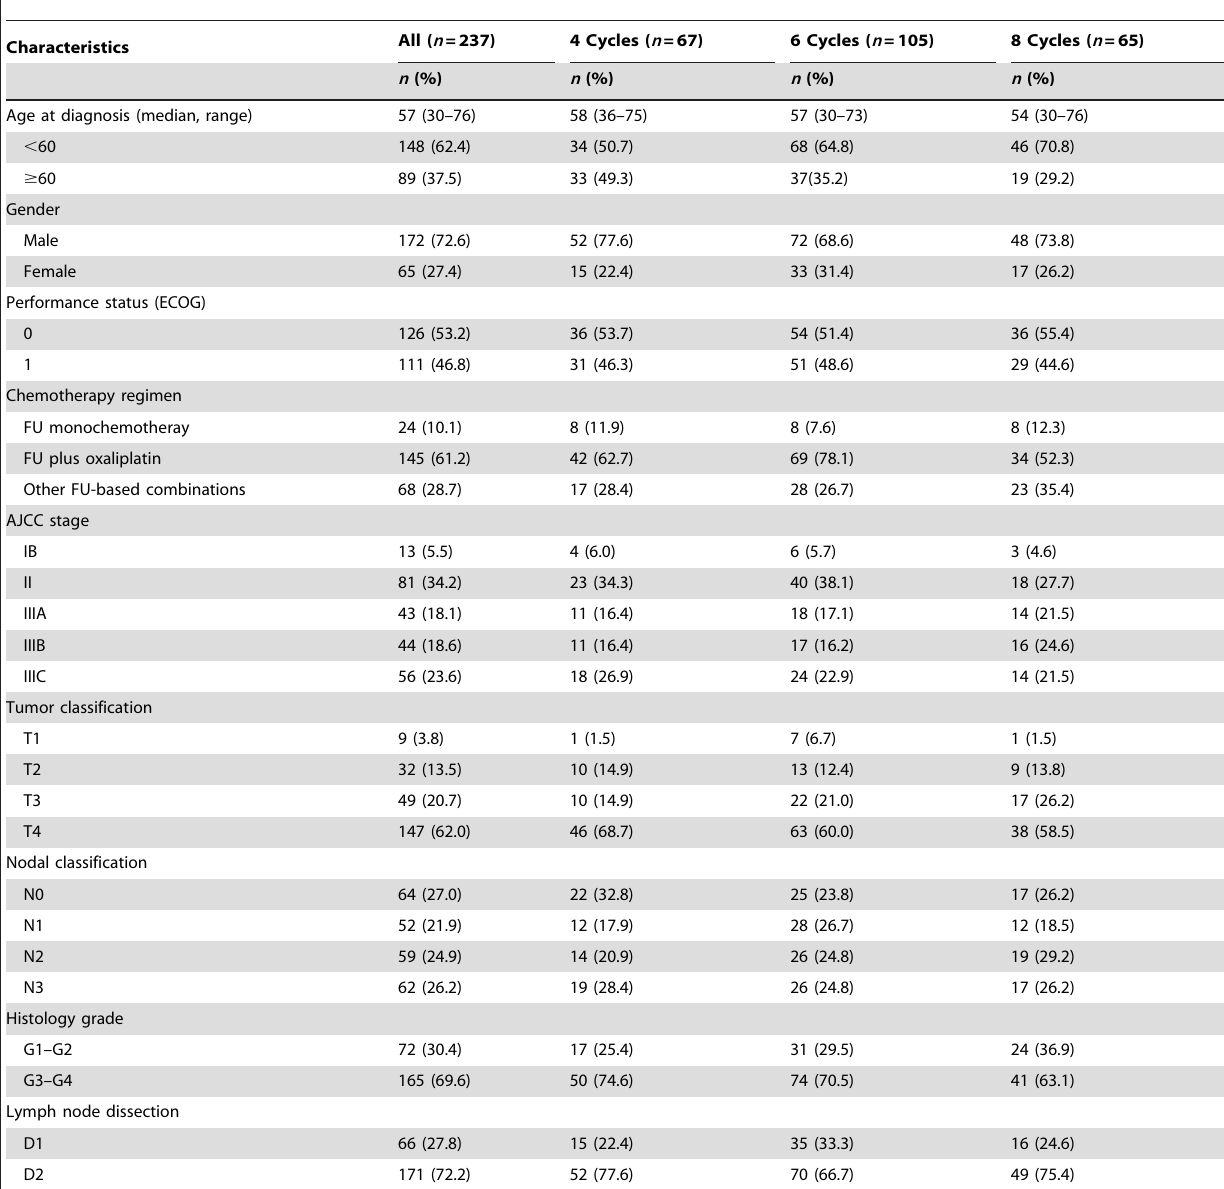
Table 1. Patient characteristics according to number of adjuvant chemotherapy